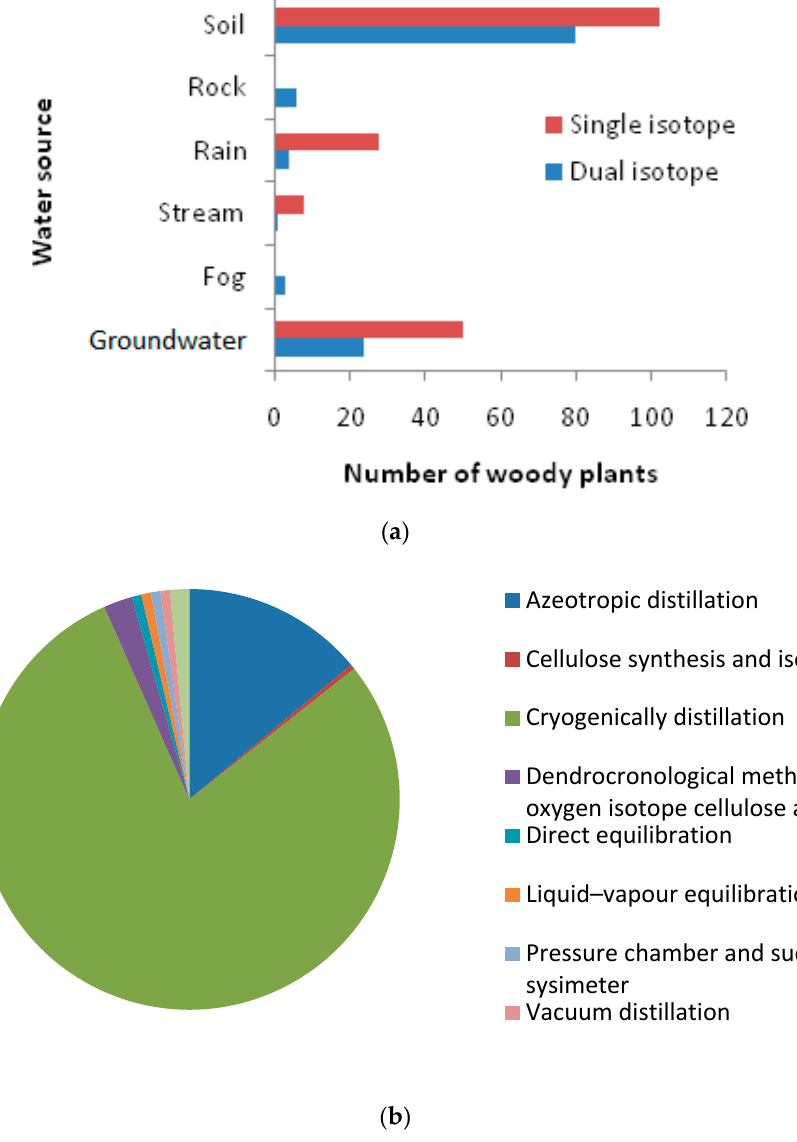
Figure 7. ( a ) Water source variation due to changes in isotopic approach; ( b ) Method used for plant water source